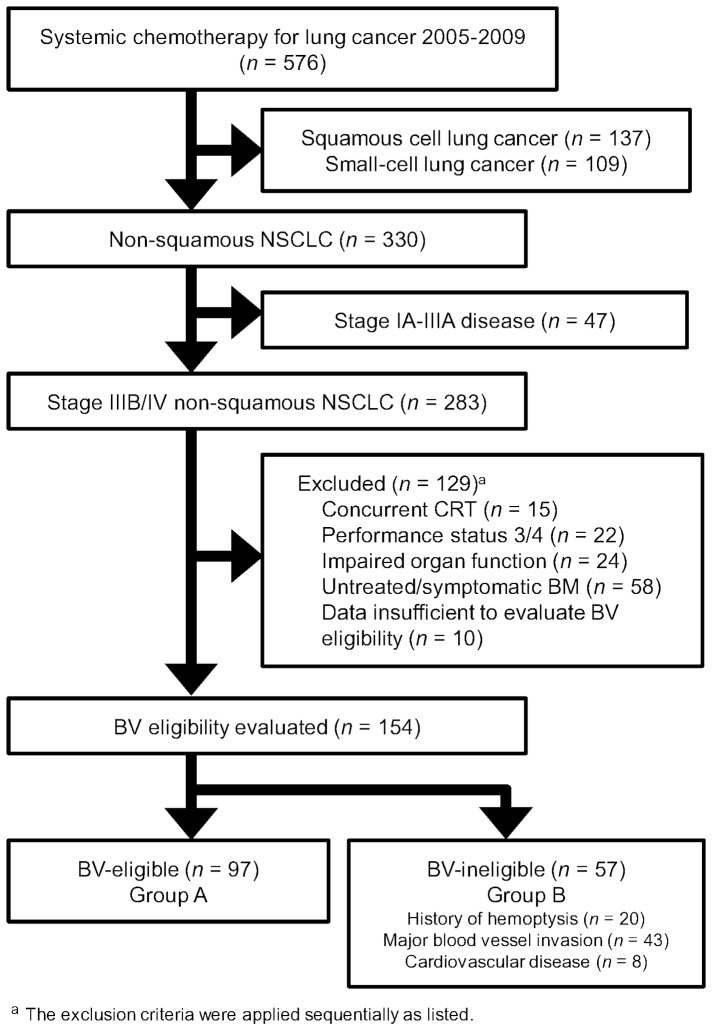
Flow chart of patients through the study.BM, brain metastasis; BV, bevacizumab; CRT, chemoradiotherapy; NSCLC, non-small cell lung cancer.